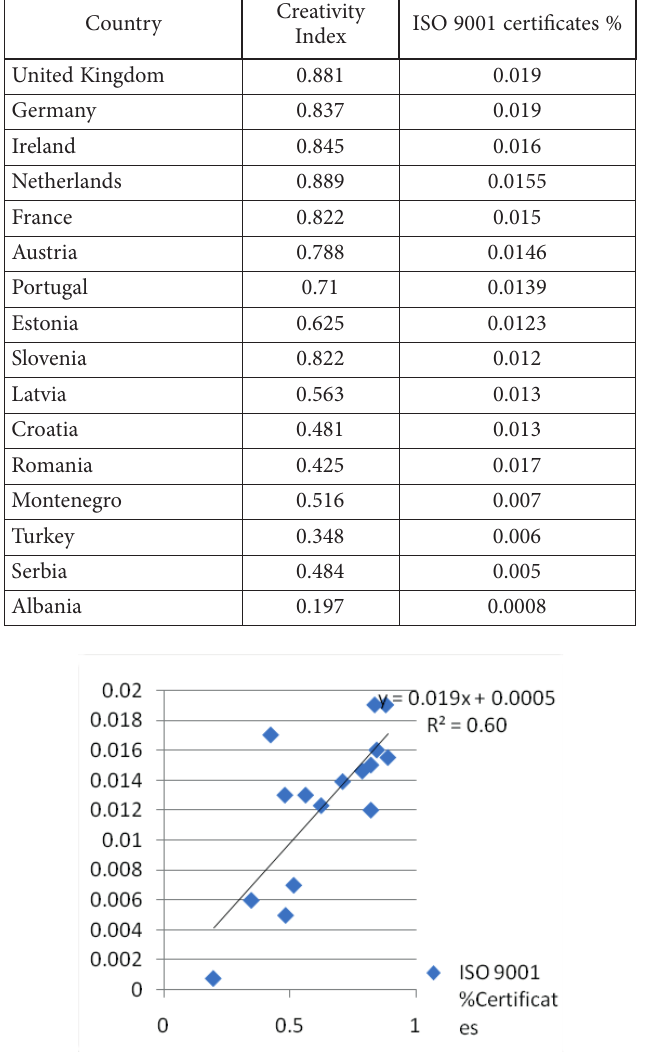
Figure 2. Relations between creativity and ISO 9001 certifi cates (source: created by